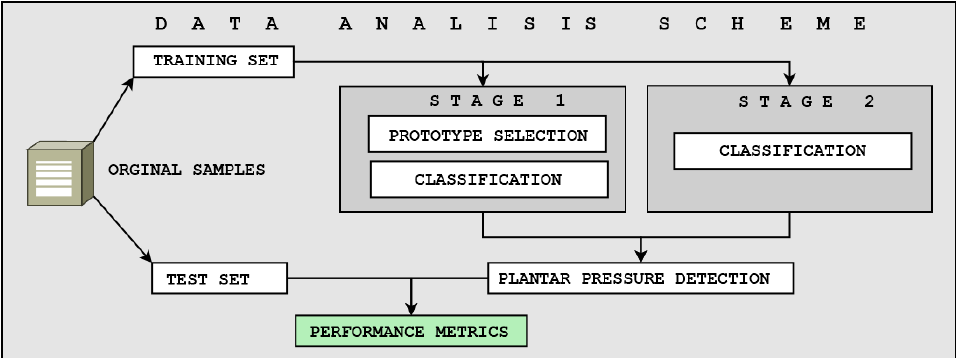
Figure 4. The proposed data analysis scheme. The first stage is composed of the prototype selection and classification. The second stage includes classification.